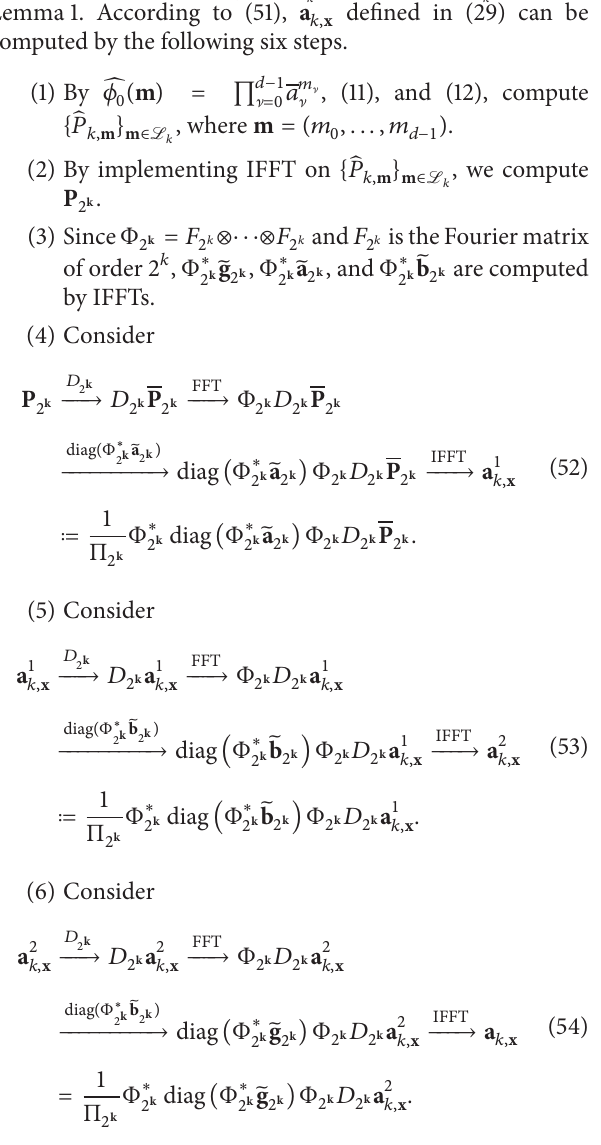
{̂𝑃 } , and 𝑘, m m ∈ L 𝑘 be as 𝑘